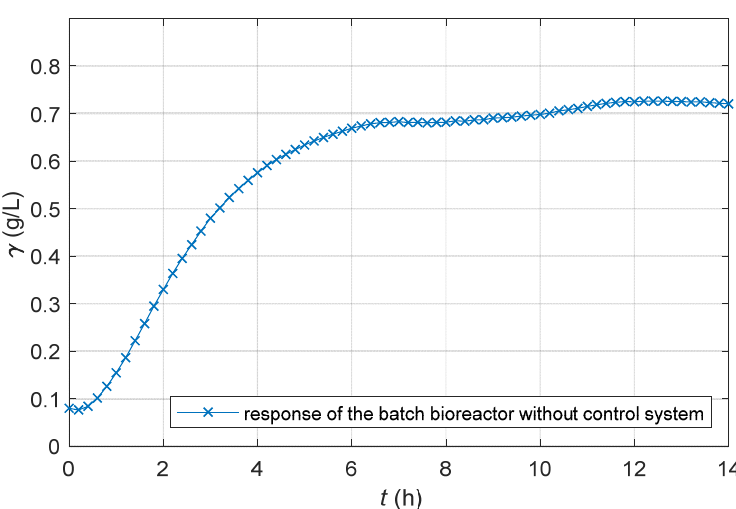
Figure 5. Time course of dissolved CO 2 concentration γ of a non-controlled laboratory batch bioreactor by constant stirrer’s speed n = 80 min − 1 .